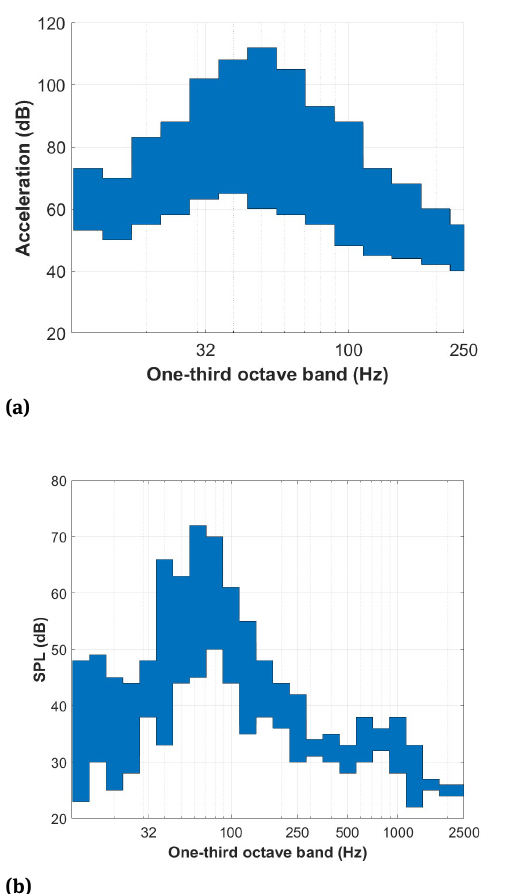
Figure 8: Envelope of 186 measurements in frequency domain: (a) vibration accelerations of buildings floor and (b) SPLs in the rooms of buildings.